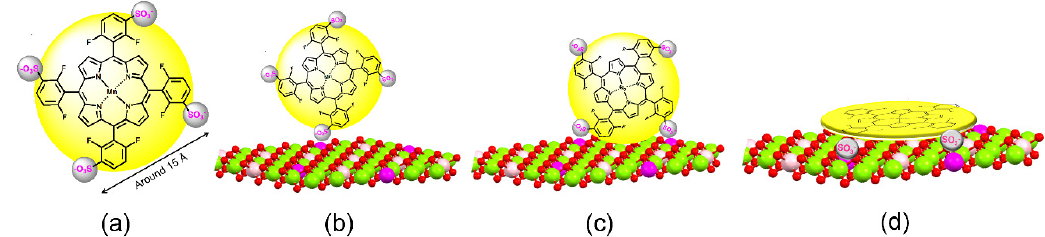
Figure 10. Schematic representation of the possible modes of MnP (yellow ball interaction with the LDH surface: ( a ) MnP; ( b ) MnP interacts only via one negative charge; ( c ) via two negative charges; ( d ) via four negative charges.